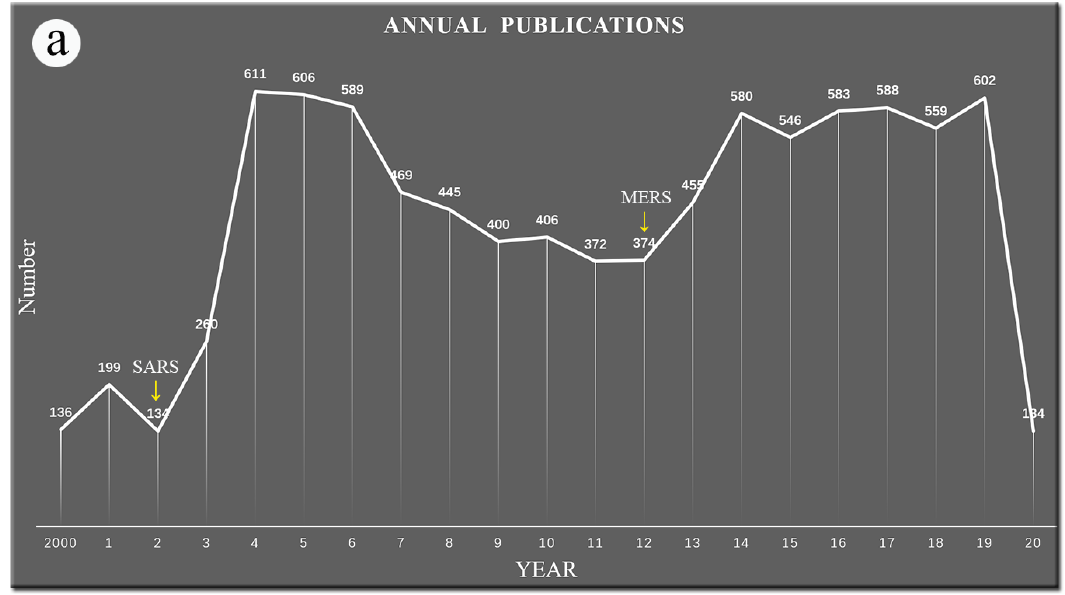
Figure 1. Flowchart of data screening and inclusion.